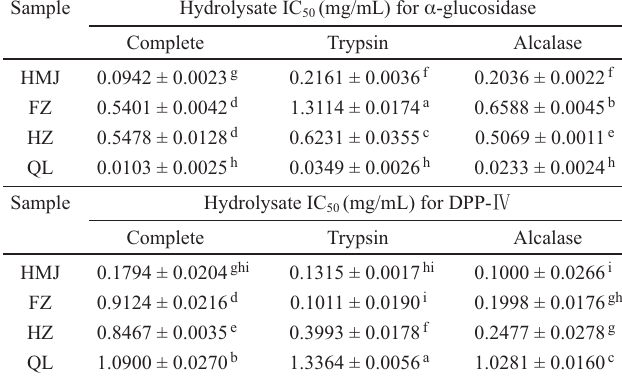
Tab. 2: IC 50 (concentration that inhibits enzyme activity by 50%) of four kinds of dark tea and their hydrolysates generated by trypsin and Alcalase against α-glucosidase and DPP-Ⅳ. Mean ± SD (n=3). IC 50 with different letters for each of the activities are significantly